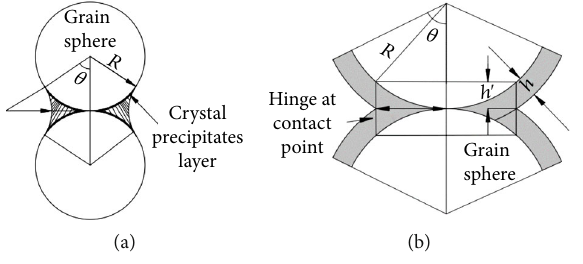
Figure 7: Particle bonding images.